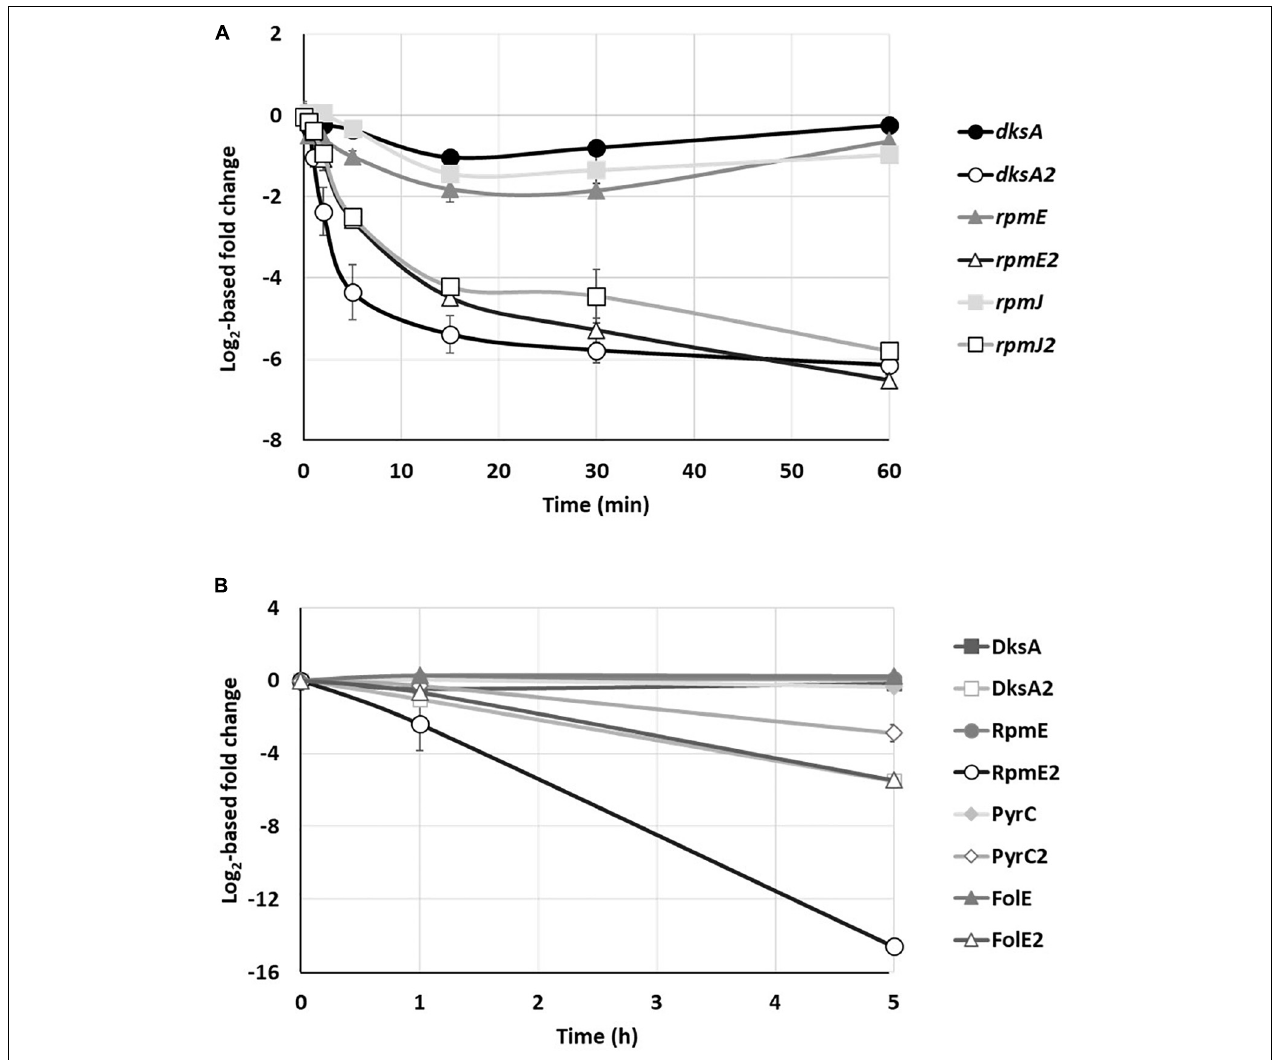
FIGURE 5 | Kinetics of C+/C– protein family. (A) Fold change of rpmE , rpmJ and dksA transcripts and their C– paralogs over time, after addition of 2 mM ZnCl 2 . (B) Fold changes in the amount of DksA, RpmE, PyrC, and FolE proteins and their C– paralog after addition of 2 mM ZnCl 2 . Mean values of fold change compared to t0 (before addition of Zn) and standard deviations (error bars) of three independent experiments are